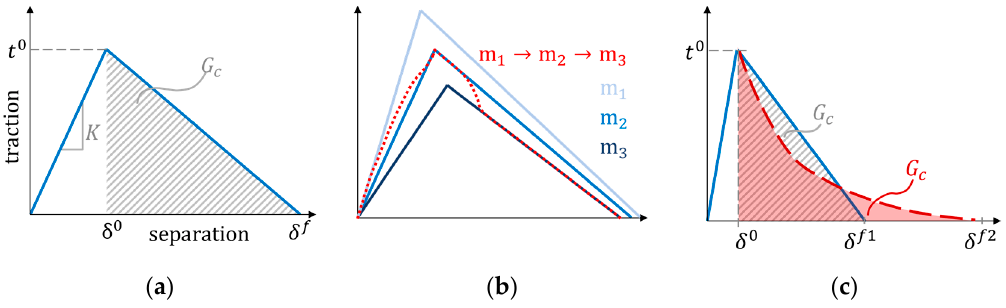
Figure 4. Schematic of ( a ) traction–separation law, ( b ) contact constitutive behaviour under moisture change during loading, and ( c ) example of cohesive law with similar fracture energy and damage initiation tractions but different softening behaviours.